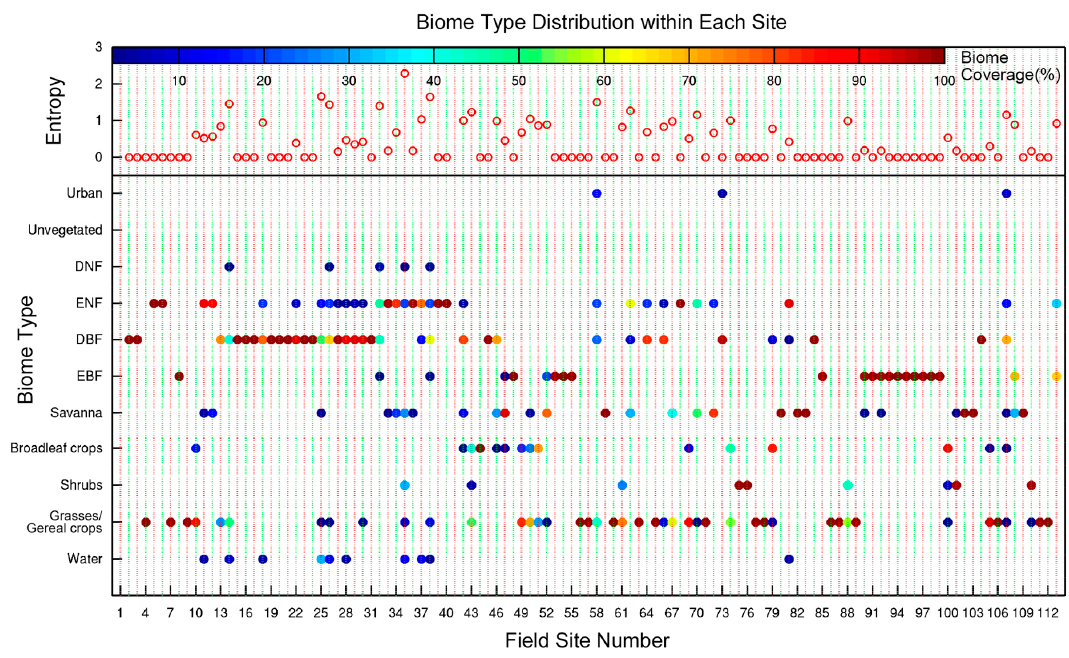
Figure 1. Biome type distribution within each 3 km × 3 km validation site based on the 500-m resolution MODIS C5 land cover product. The bottom part of the plot shows biome types and the corresponding proportion of coverage within each site. EBF, DBF, ENF and DNF stand for “Evergreen Broadleaf Forest”, “Deciduous Broadleaf Forest”, “Evergreen Needleleaf Forest” and “Deciduous Needleleaf Forest”, respectively. The top part of the plot shows the biome type information entropy of each site calculated using Equation (5). Zero means there is only one biome type in the site or the site is a homorganic site. A larger entropy value means larger heterogeneity. Table 2. Quality control for the four products under study.